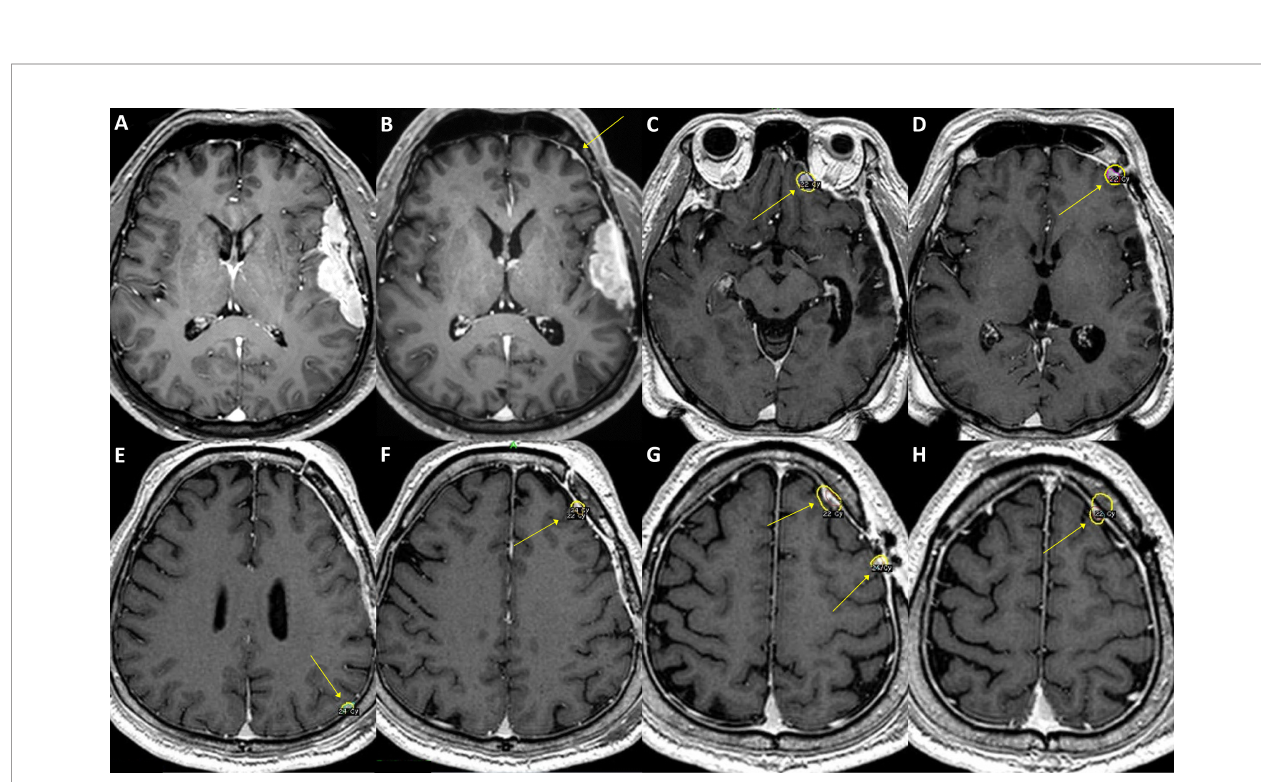
FIGURE 3 | A case of convexity meningioma with TERT promoter mutation. A 52-year-old male presented with an en plaque meningioma in the left temporal convexity (A) . The tumor was partially resected during the initial surgery, and the residual superior temporal mass, severely adhered to the brain parenchyma and the vascular structures in the Sylvian fi ssure, was further treated by adjuvant stereotactic radiosurgery. However, the tumor regrew (B) , and another operation was performed after two years from the initial treatment. The specimens from the fi rst and second operations both presented C250T TERT promoter mutation. Although the primary lesion was successfully removed, a new, tiny lesion at the left frontal convexity ( B , arrow) had been rapidly grown at six-month follow-up, in addition to other multiple distant lesions ( C – H , arrows). The patient underwent stereotactic radiosurgery six times over the next fi ve years, one more reoperation at the primary location, and then another two times of stereotactic radiosurgery for the refractory tumors. In 9 years from the initial treatment, the leptomeningeal spread of the tumor cells was con fi rmed by cerebrospinal fl uid examination, and the patient received a ventriculoperitoneal shunt operation for